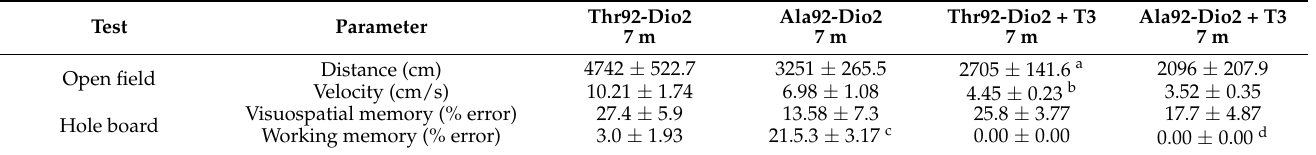
Table 2. Cognitive and behavioral phenotype of 7-old-month male Ala92-Dio2 mice treated with T3.